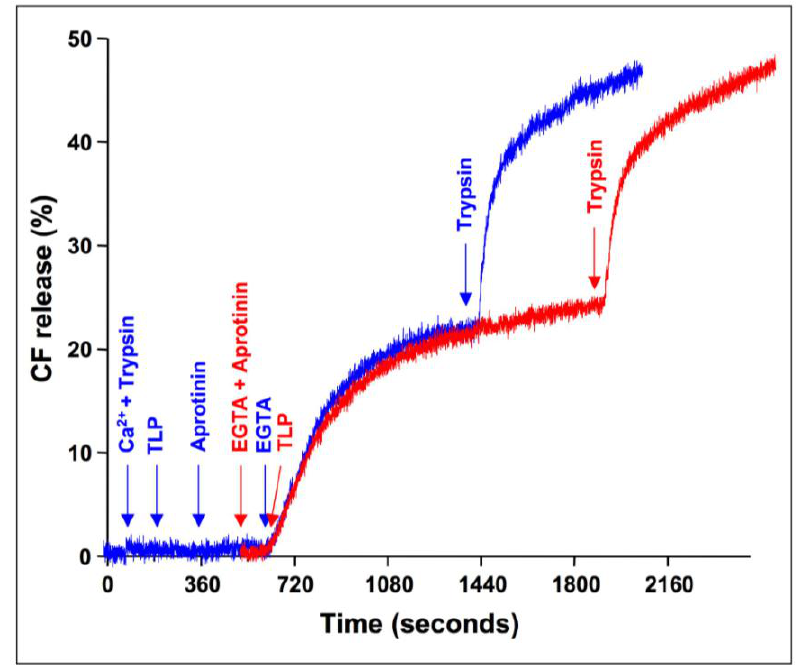
FIGURE 2 . CF release induced by rotavirus. Purified TLPs grown in the presence of trypsin were added at time zero to a cuvette containing CF-loaded vesicles (70 m M ) from pig jejunum suspended in standard assay medium (100 m M sorbitol and 200 m M Tris HCI in 20 m M HEPES- 10 m M Tris [pH 7.4]). Blue trace : TLPs were added to the cuvette containing 1 m M Ca 2+ to maintain TLP structure and trypsin (0.01 mg/ml) to hydrolyze VP4 on TLP in situ . The action of trypsin was blocked after 5 min by the addition of aprotinin (0.03 mg/ml), and then EGTA (10 m M ) was added to solubilize the outer layer of TLP and elicit membrane permeabilization. After a plateau was reached, excess trypsin (0.1 mg/ml) was added to hydrolyze the solubilized proteins (VP5*, VP8*, and VP7). Red trace : TLPs were added to the cuvette containing aprotinin (0.03 mg/ml) to block any action of contaminant trypsin and EGTA (10 m M )